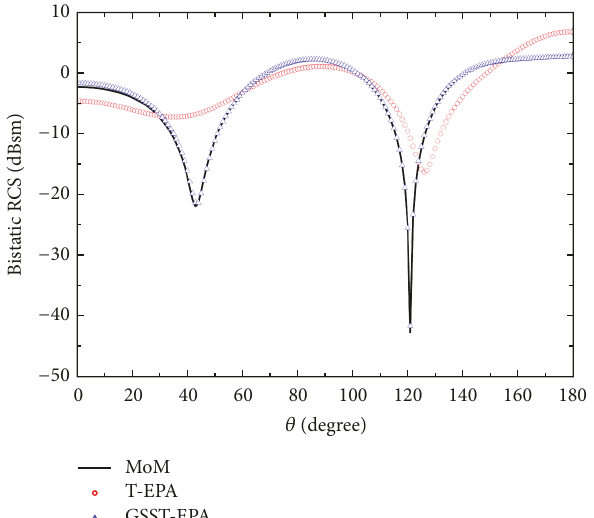
Figure 9: The bistatic RCS of two PEC spheres with center distance 0.605 m.